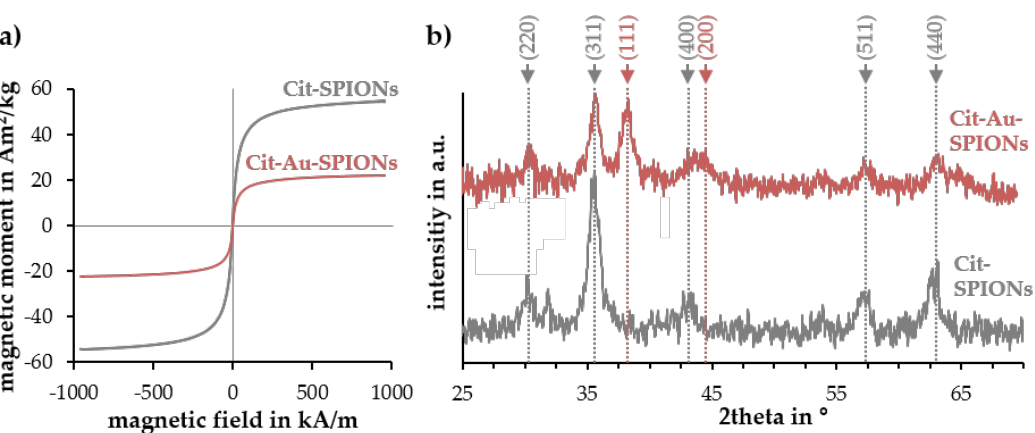
Figure 4. ( a ) Magnetization curves and ( b ) XRD measurements of Cit-SPIONs and Cit-Au-SPIONs. Peak identification was performed using [41, 42].